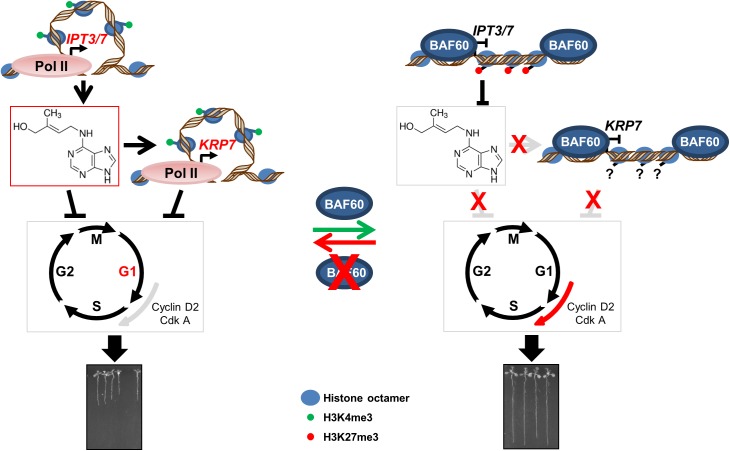
Model for the role of BAF60 in root development.In the wild-type root tip, BAF60 binds IPT3, IPT7 and KRP7 and inhibits their expression during root development. In contrast, in BAF60 RNAi lines, these genes are overexpressed due to formation of gene loops and augmentation of H3K4me3 level. This blocks the cell cycle in G1 phase and inhibits root development.